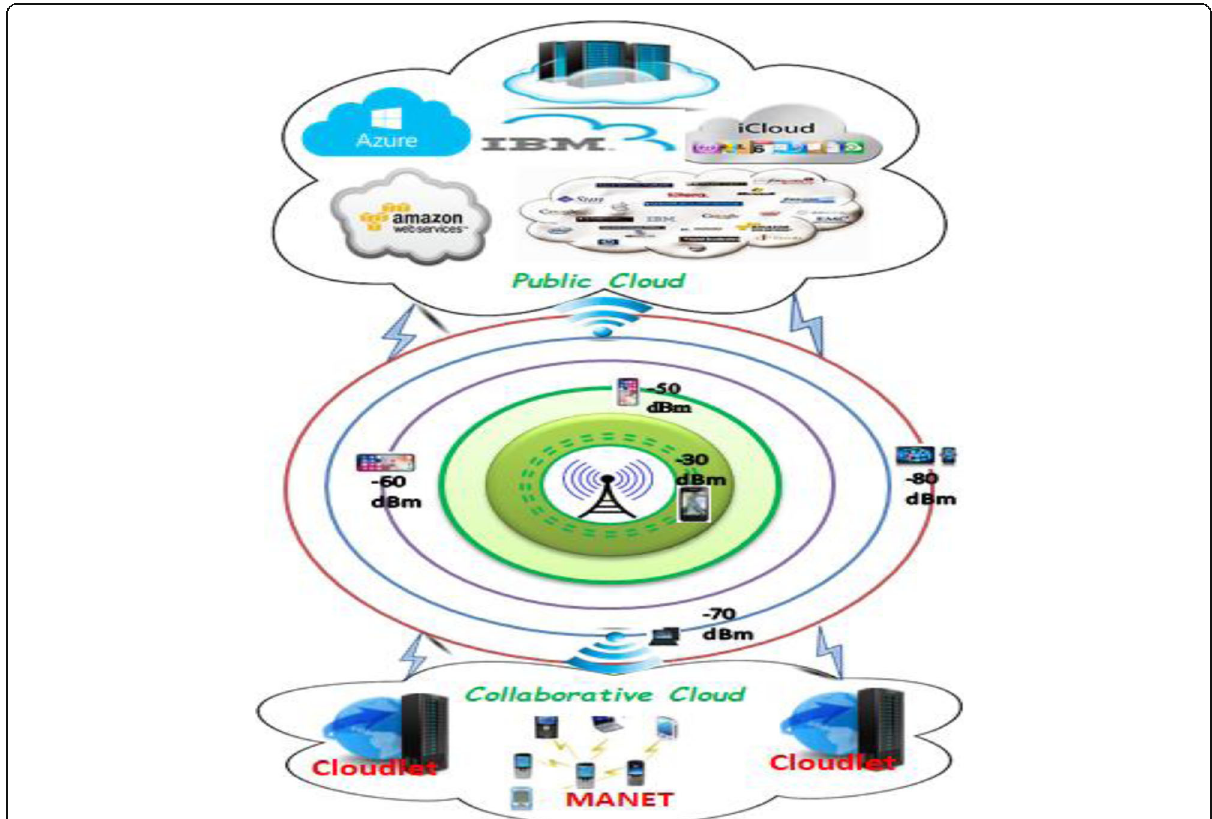
Fig. 2 Proposed architecture view. This architecture consists of three core components: a mobile device, distant cloud, and collaborative-cloud (cloudlet + mobile ad-hoc cloud). In the collaborative-cloud, a requesting mobile device able to share P2P nodes ’ computing resources based on computational requirements, and with respect to their Wi-Fi signal